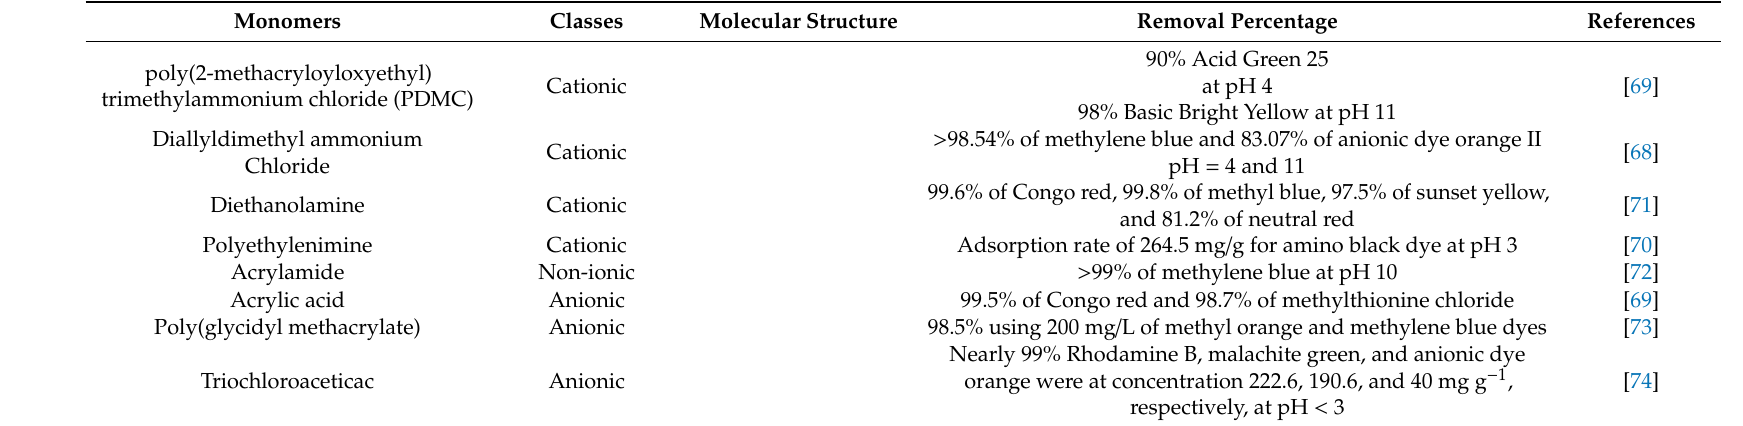
Table 6. Examples of monomers introduced in graft